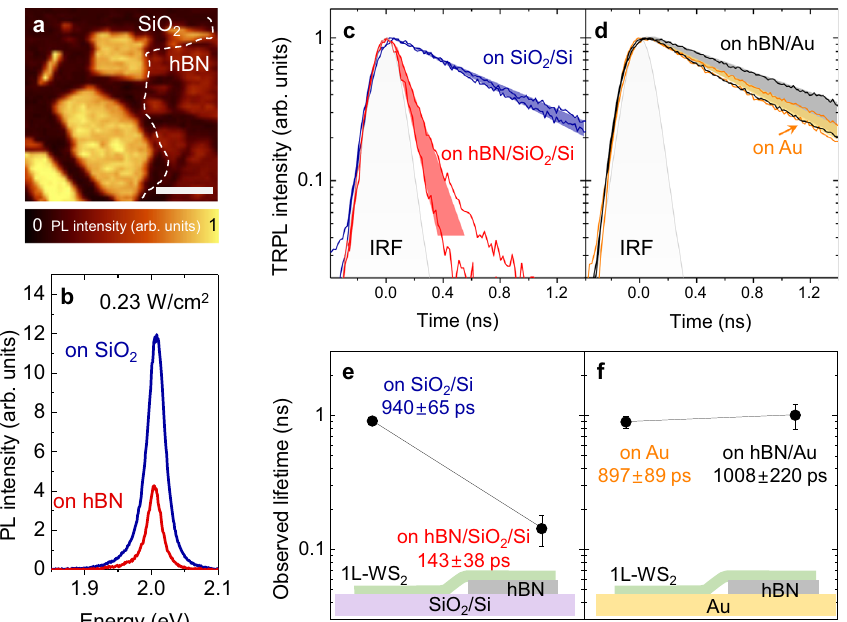
Fig. 2 Excitonic PL at the low-density regime. a PL intensity image and b PL spectrum of 1L-WS 2 on SiO 2 (dark blue) out of the white dashed region in a and that for 1L-WS 2 on hBN/SiO 2 (dark red) from the dashed area in a , respectively. The scale bar in a corresponds to 4 μ m. Normalized TRPL data obtained at an exciton density below 5 × 10 8 cm − 2 , free from EEA, from c 1L-WS 2 on SiO 2 (dark blue) and hBN/SiO 2 (red) and d 1L-WS 2 on Au (orange) and hBN/Au (black), respectively. Corresponding PL lifetimes are shown with the values in e and f with the same colors of the substrate conditions in c and d . The schematic structures of the samples are displayed, in which the solid lines are the guides to the eye. The colored shades in c and d indicate the range of the data trace, and the error bars in e and f indicate the standard deviation, observed from other samples with the same